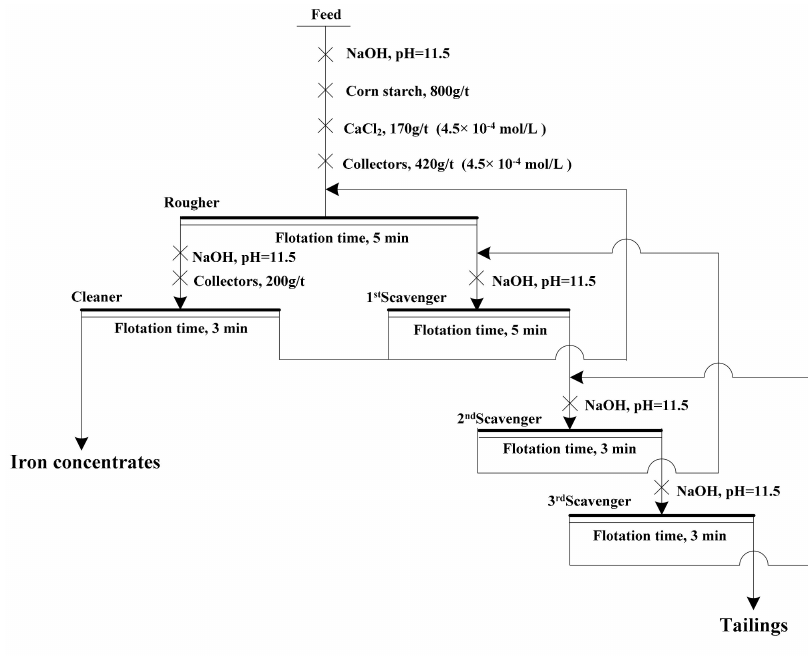
Figure 3. The locked cycle flowsheet of bench-scale